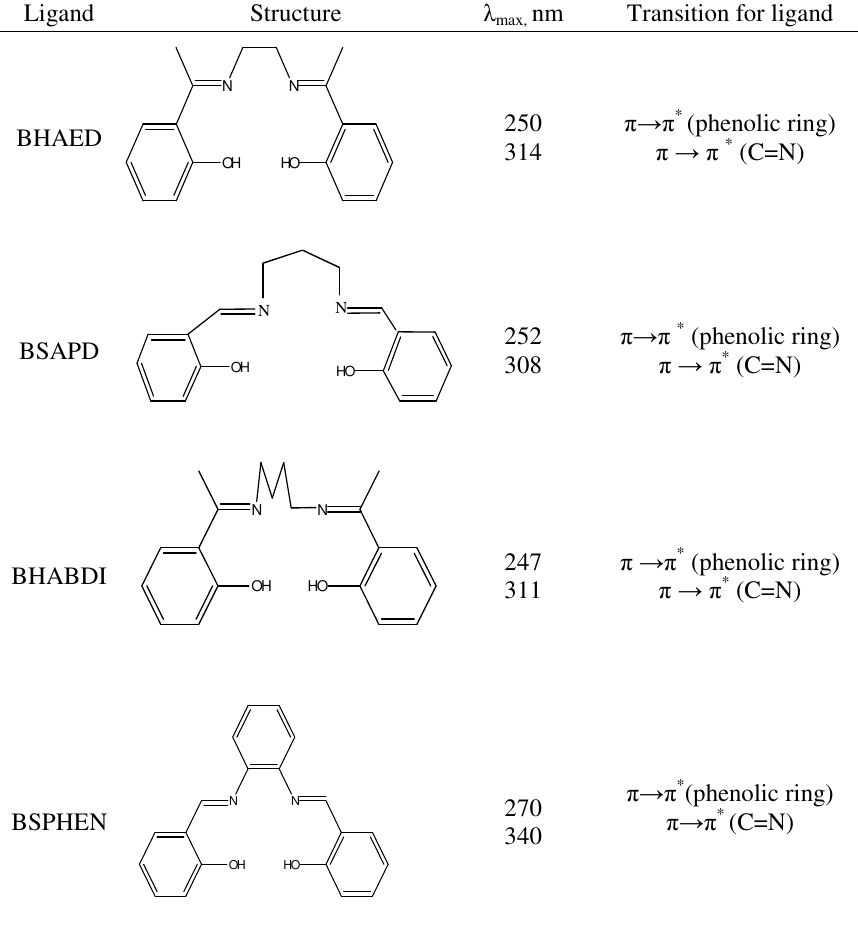
Table 1. Structure of